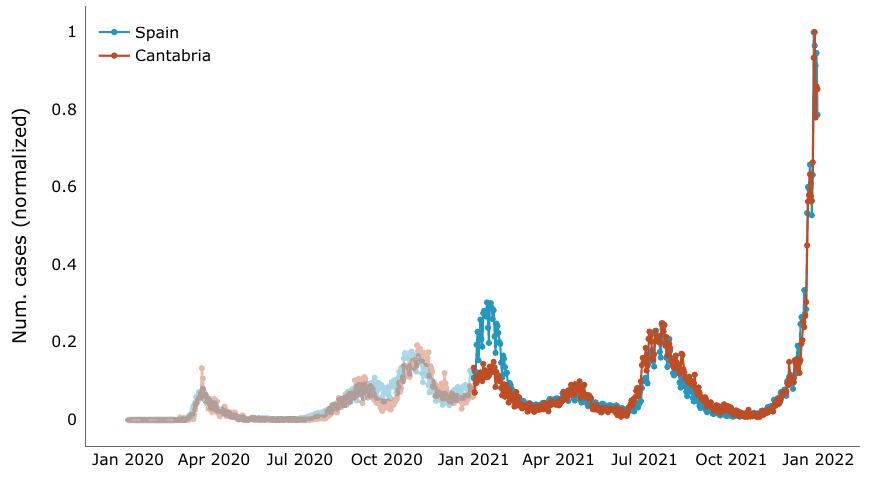
Figure 1. Daily COVID-19 confirmed cases (normalized) in Spain and in Cantabria autonomous community. Transparency is added to data outside our considered time range (data before